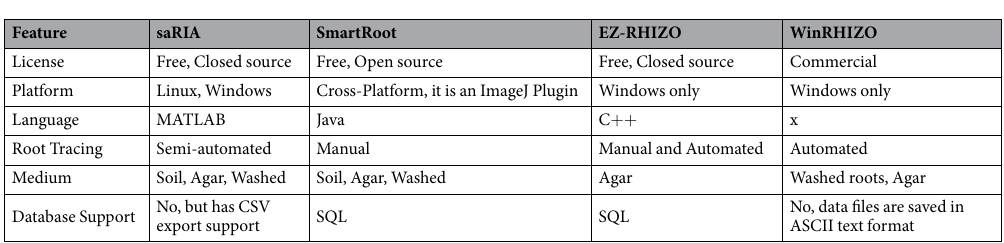
Table 2. The feature comparison of saRIA with other softwares for root segmentation and trait